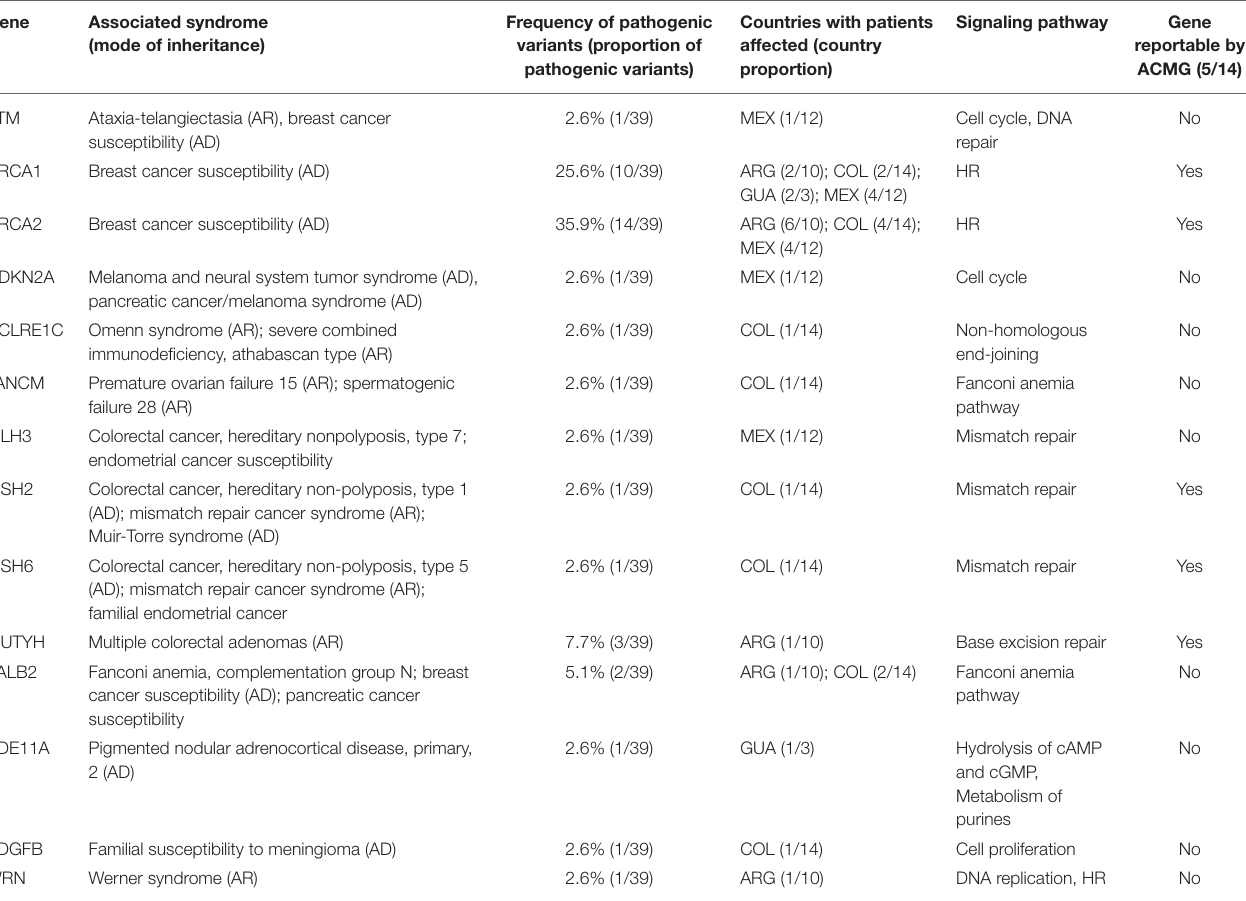
TABLE 4 | Hereditary syndromes associated with the pathogenic variants detected in 222 individuals. Gene Associated syndrome (mode of inheritance)